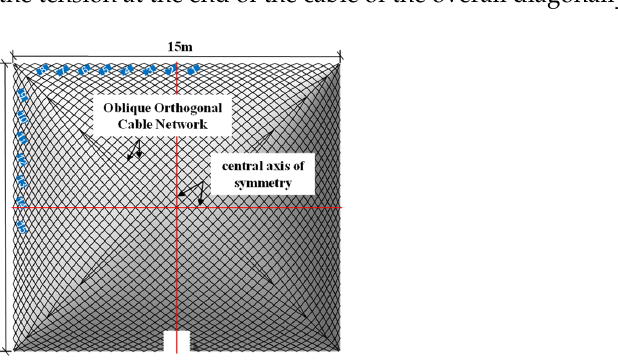
Figure 22. Cable tension variation curve. Figure 21. Sensor number. Table 1. Cable end tension values of different measuring points. Along the Long Side Along the Short Side Measuring Point Cable Tension(kN) Measuring Point Cable Tension(kN)